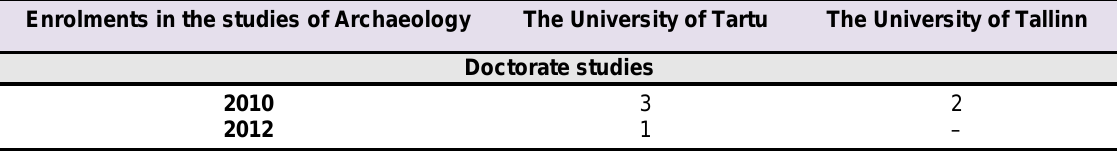
Table 14 - Enrolments in the Doctorate studies of Archaeology